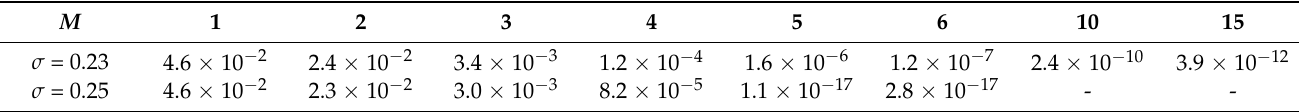
Table 7. The MAE versus M at t = 1 for different σ